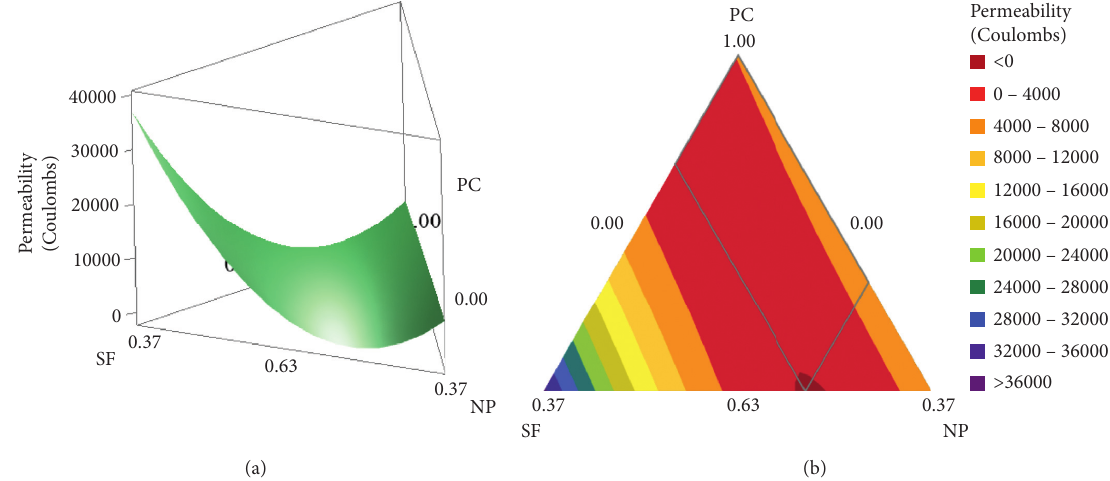
Figure 11: Permeability isoresponse of concrete that incorporates a blend of binders ( w / b ) � 0.40). (a) Surface. (b) Contours.